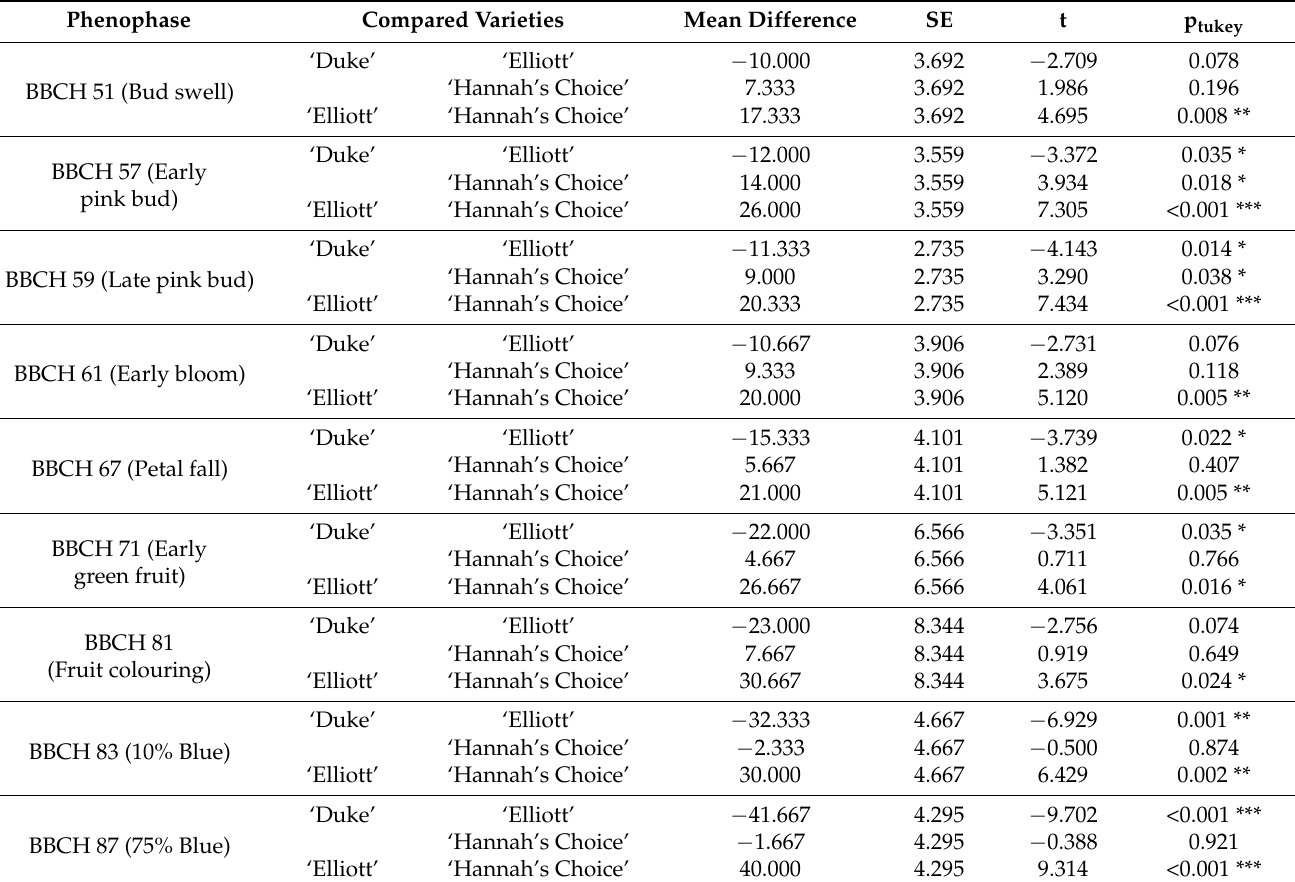
Table 4. Analysis of variance (ANOVA) on phenology under cultivar